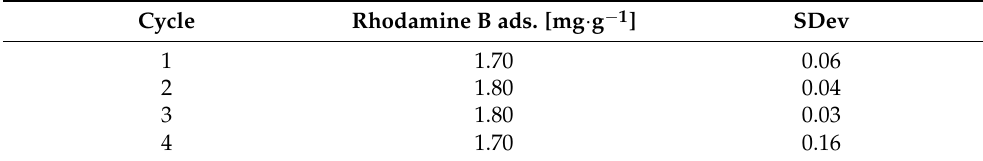
Figure 7. Amount of Rhodamine B (mg dye/g sample) adsorbed on silica particles after 360 min, for the pristine sample (cycle 1) and after three regeneration cycles (from 2 to 4). The reported values are the average of three measurements. Table 4. Amounts of Rhodamine B adsorbed by silica particles after a contact time of 360 min for each cycle. The reported values with the corresponding standard deviation are the average of three